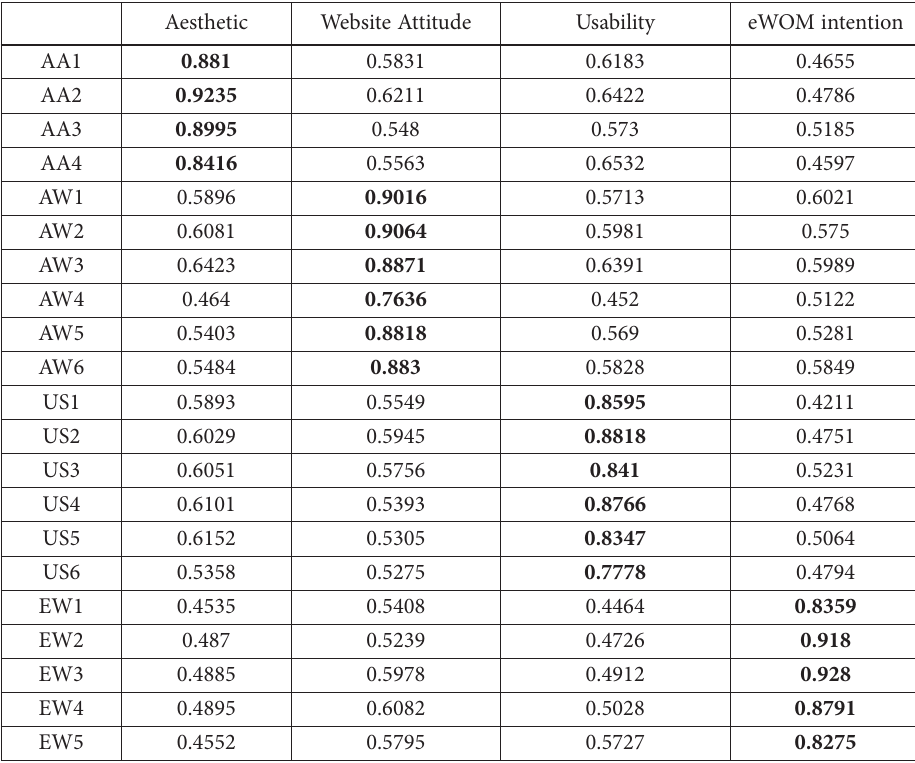
Table 3. Loadings and Cross-loadings of measurement items Aesthetic